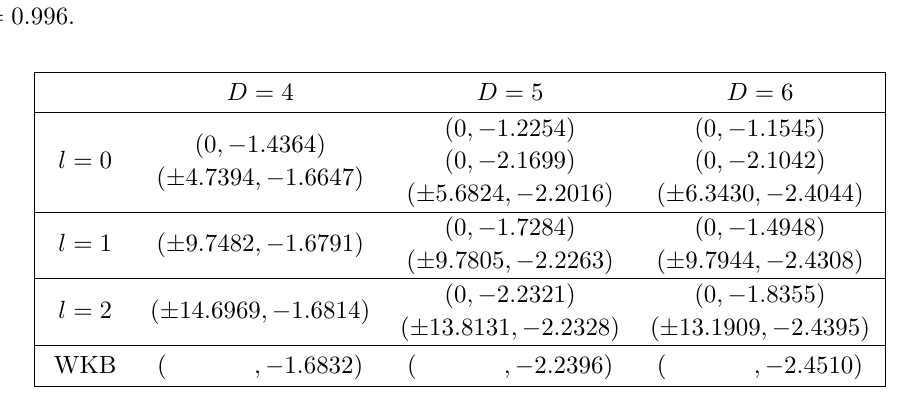
= 0 : 27, and (cid:3) max